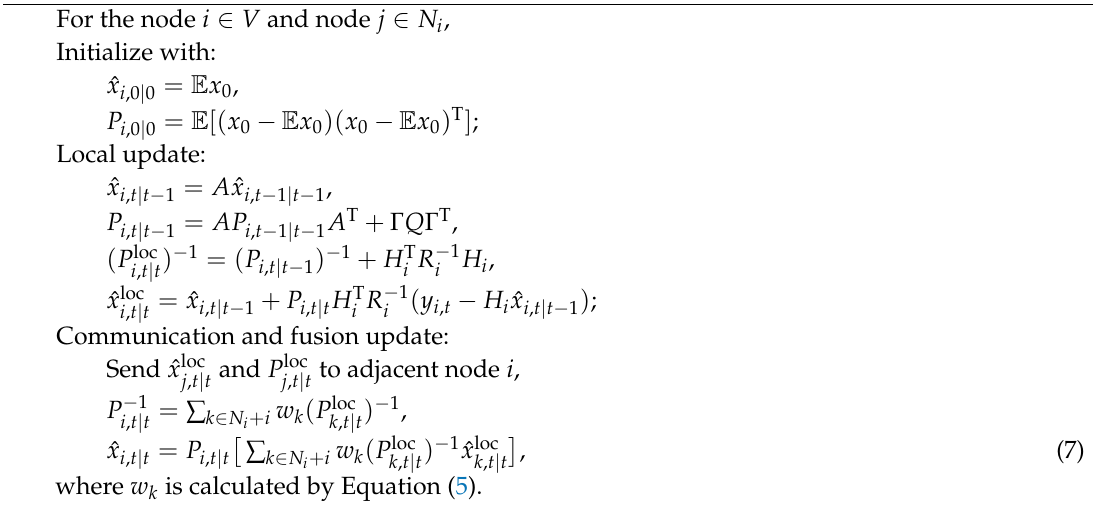
Algorithm 3: A diffusion distributed Kalman filter with the CI